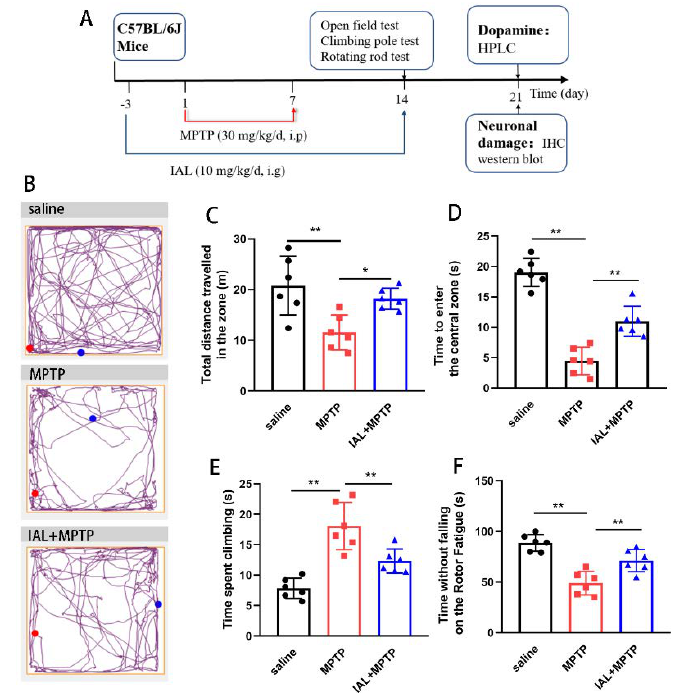
Figure 1. IAL alleviates the mobility of MPTP-induced PD mice. ( A ) Experimental process diagram. ( B – D ) The effect of IAL on the motor distance and time to enter the central area in MPTP-injected mice was tested via open field experiment. ( E ) The effect of IAL on the coordination ability of MPTP-injected mice was tested via a pole-climbing experiment. ( F ) The effect of IAL on the fatigue resistance of MPTP-injected mice was tested via rotating rod experiments. Results are shown as means ± SEM (n = 6). * p < 0.05, and ** p < 0.01 stand for biologically significant